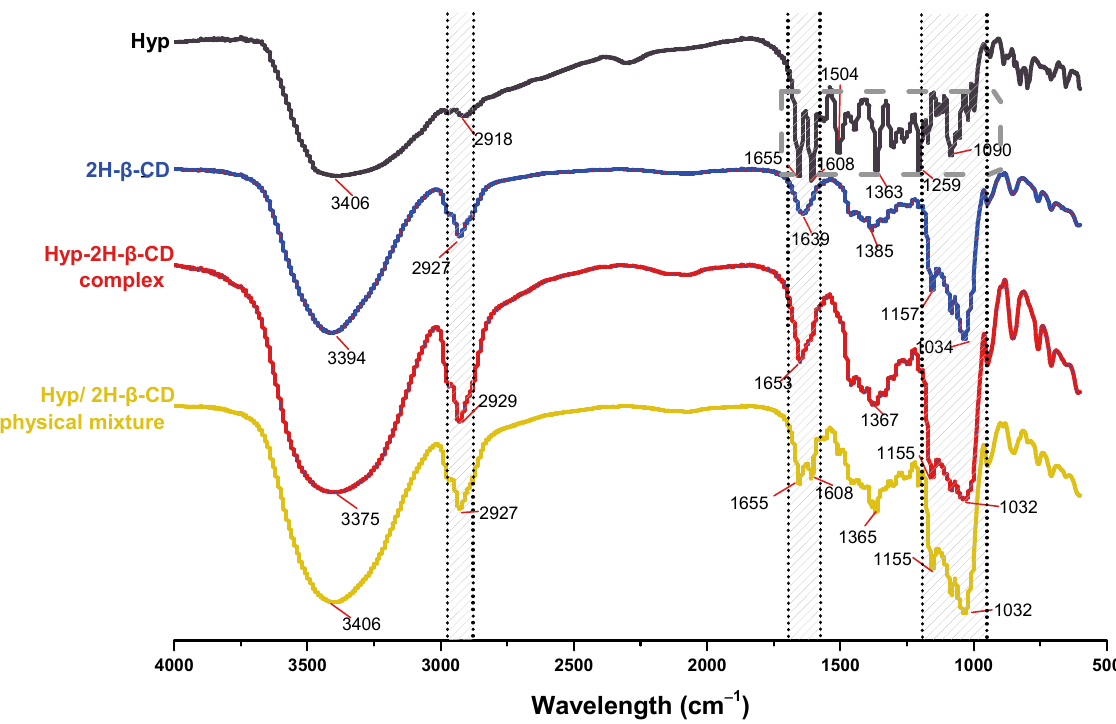
Figure 7. FTIR spectra of Hyp, 2H- β -CD, Hyp–2H- β -CD, and physical mixture.